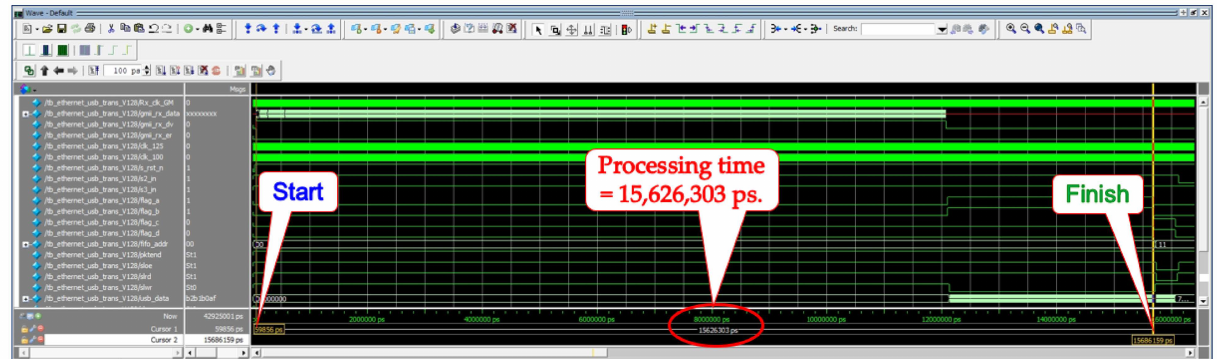
Figure 22. The processing time of the transformation and transmission between Modbus TCP packet and USB data at the maximum data of 1460 bytes, the processing clock frequency of Ethernet PHY of 125 MHz, and the processing clock frequency of USB controller of 100